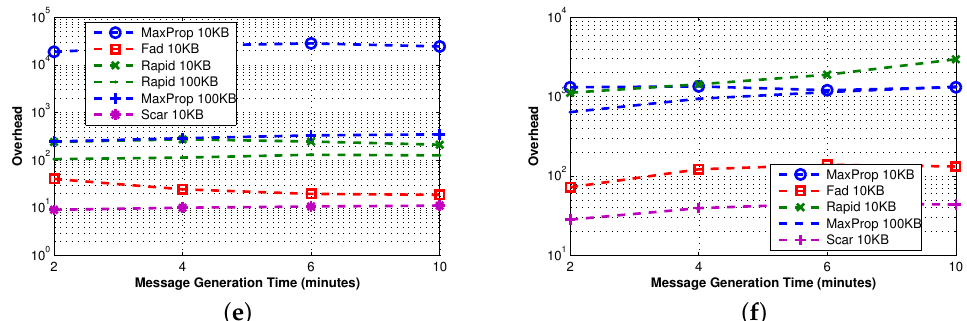
Figure 7. Advanced protocols: LW ( a , c , e ) vs. Infocom ( b , d , f ). For the sake of readability: if the difference between the 100-KB and 10-KB cases for a protocol is within 5%, we delete the 100-KB case.